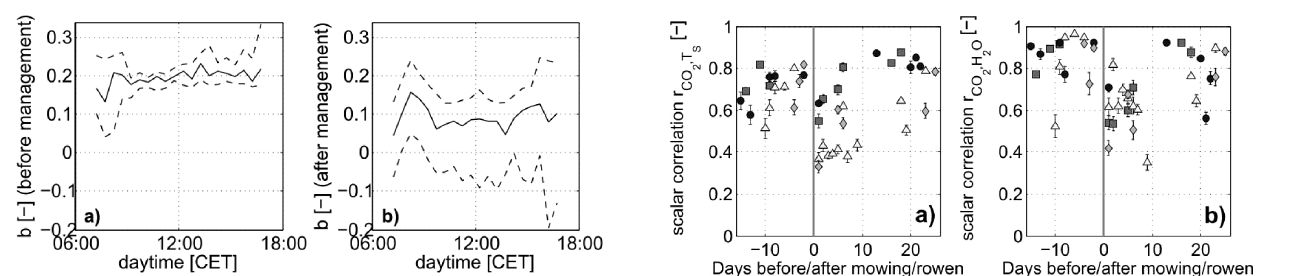
Figure 3. Absolute scalar correlation coefficients between CO 2 and sonic temperature T S (a) and CO 2 and water vapor H 2 O (b) . Nega- tive x -axis values indicate days before and positive values days af- ter mowing and rowen, respectively. Dark squares represent rowen data in September 2009, bright upward triangles represent mowing in July 2010, black circles represent rowen in September 2010, and grey diamonds represent the late mowing in August 2011. The error bars show standard errors of the daily mean of r between 09:00 and